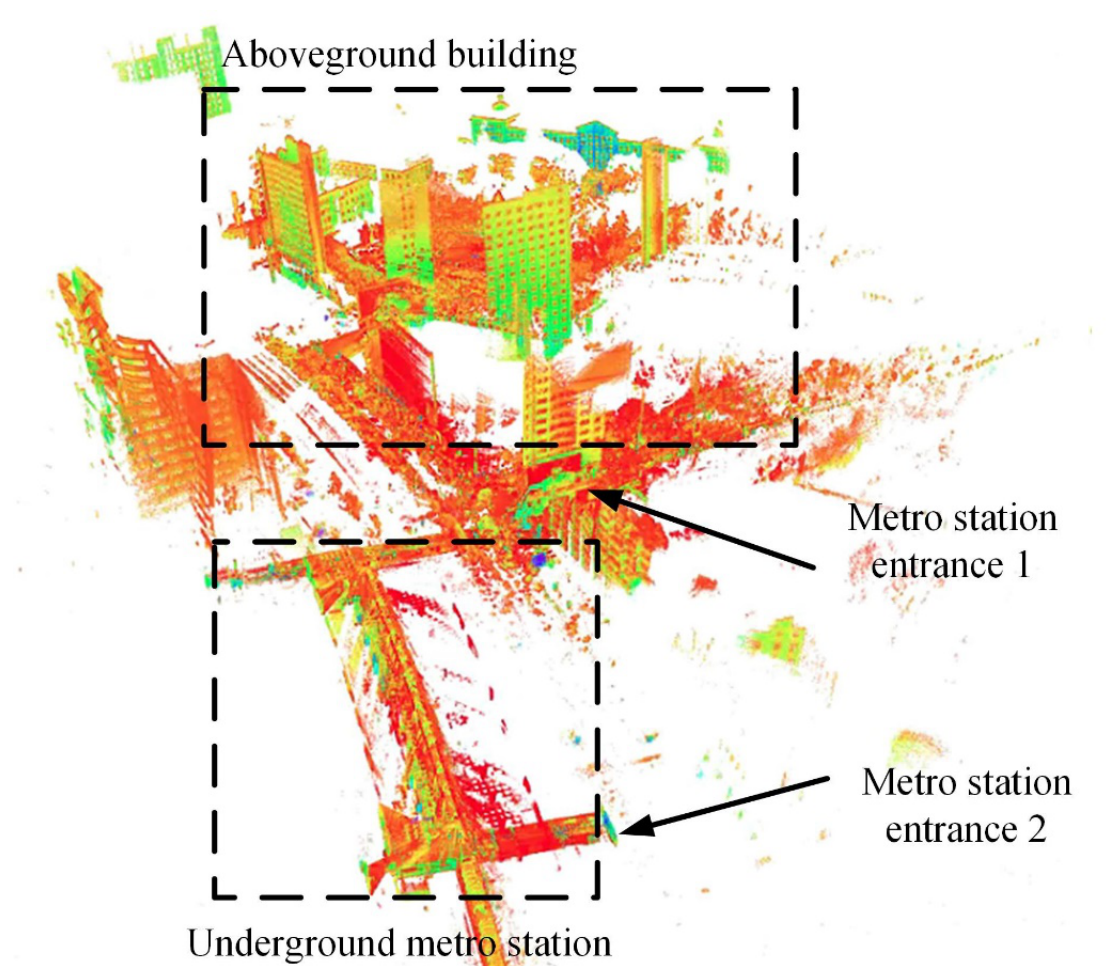
Figure 5 Overview of the aboveground and underground point clouds collected by the helmet-based laser scanning